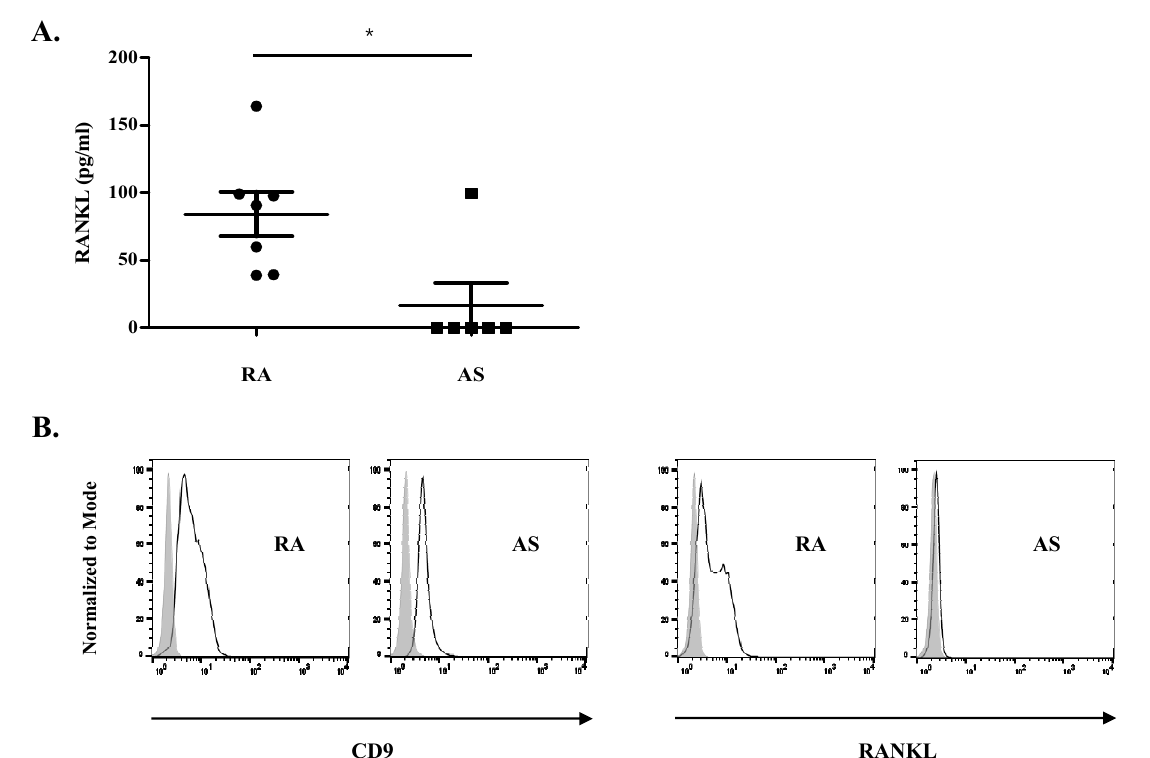
Figure 3. RANKL expression on synovial exosomes. ( A ) Exosomes from rheumatoid arthritis (RA) and ankylosing spondylitis (AS) patients were lysed for analysis of RANKL concentration in synovial exosomes. The levels of RANKL Figure 3. The expression of RANKL on synovial exosomes . A . Exosomes from RA and AS patients were lysed for analysis were measured using sandwich enzyme-linked immunosorbent assay (ELISA). Data are presented as the mean ± SEM. of RANKL concentration in synovial exosomes. The levels of RANKL were measured by sandwich ELISA. Data are presented * p < 0.05 vs. disease control, AS. ( B ) CD9 or anti-RANKL antibodies-coated magnetic beads and stained with Exo-FITC. as the mean ± SEM. * p < 0.05 vs. disease control, AS. B. Synovial exosomes from RA and AS patients (unshaded histograms) The expression of CD9 and RANKL are presented by flow cytometric or negative control (PBS; gray-shaded histogram) were incubated with biotinylated anti-CD9 or anti-RANKL antibodies-coated magnetic beads and stained with Exo-FITC. The expression of CD9 and RANKL was presented by flow cytometric histograms.